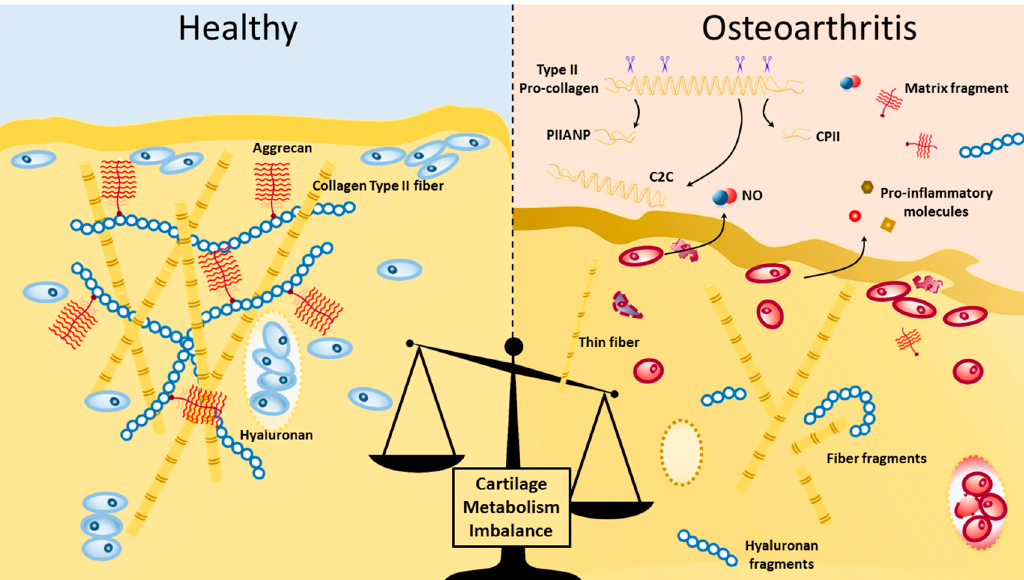
Figure 1. Visual representation of some of the elements of cartilage structure and matrix turnover changes in healthy and osteoarthritic cartilage. Type II collagen fibrils forms an intrinsic network in conjunction with aggrecan aggregates with a hyaluronic acid backbone. In normal physiological conditions, cartilage tissue integrity is maintained by an active turnover of the extracellular matrix, mediated on-site by matrix metalloproteinases (MMPs). In osteoarthritis (OA), there is increased proteolytic damage to matrix molecules in cartilage and remote sites, which can activate receptor signaling pathways, coupled with downregulation of synthesis of collagen and proteoglycan molecules. During OA, chondrocytes also produce and release pro-inflammatory molecules, such as iNOS, interleukin (IL)1, -6, -17, tumor necrosis factor β (TNF β ), interferon (IFN)-alpha, among others.